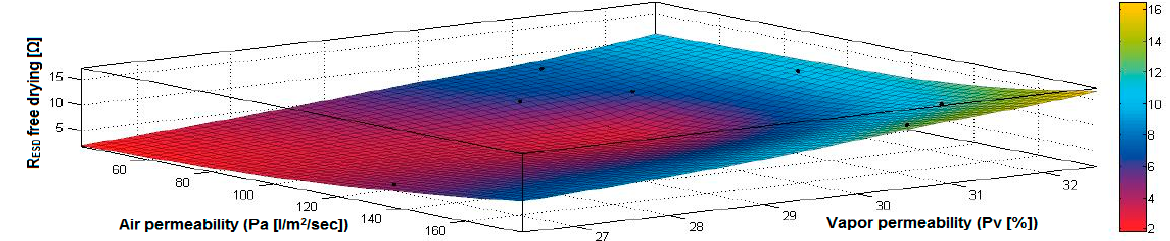
Figure 22. 3D representation R ESD free drying =f(Pv, δ ) for samples preliminarily treated in RF plasma O 2 using RF 1 genera-